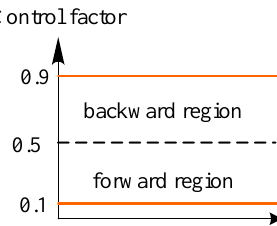
Figure 3. Probability map of control factor for the control factor, CV = 0.5. Energies 2018 , 11 , x FOR PEER REVIEW